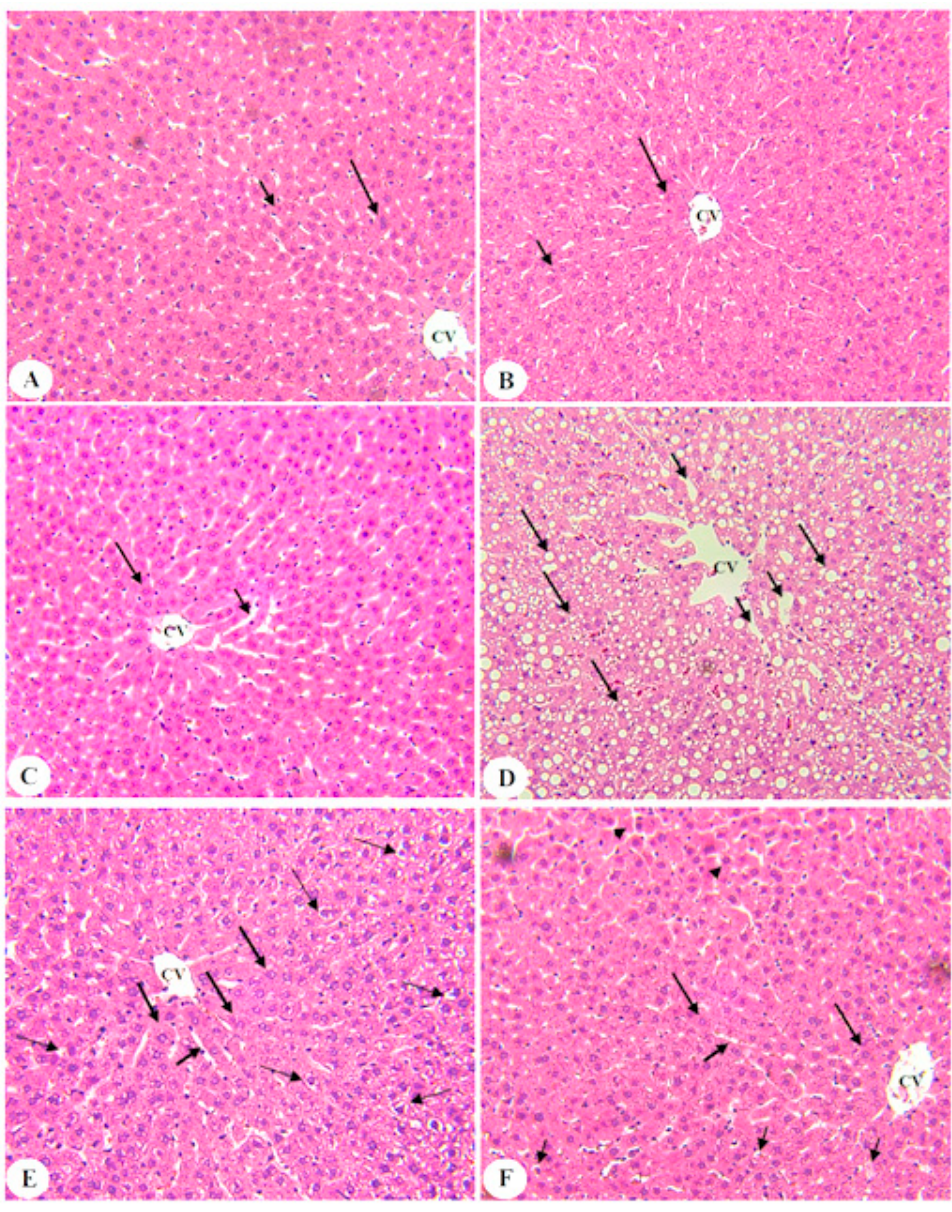
Figure 5. Photomicrographs of the liver section of all groups of rats as stained by hematoxylin and eosin (H&E) staining; 200 × . ( A – C ) show the control, control + BE (250 mg/kg), and control + BE (500 mg)-treated rats and showing normal hepatocytes structure (long arrow) radiating from a central vein (CV). Note the normally sized sinusoids (short arrow). ( D ): was taken from a T2DM-induced rat and showed dilated CV with increased cytoplasmic fat accumulation and ballooning (long arrow) in the hepatocytes. The sinusoids were abnormally dilated (short arrow). ( E ): was taken from a T2DM + BE (250 mg/kg)-treated rats and showed an improvement in the structure of the hepatocytes. Although some livers appear normal with no fat accumulation (long thick arrow), many hepatocytes remained filled with fat droplets (long thin arrow). In addition, most of the sinusoids appeared normally sized (short arrow). ( F ): was taken from a T2DM + BE (500 mg/kg) and showed almost normal morphology with those observed in control, with normal hepatocytes (long arrow) and sinusoids (short